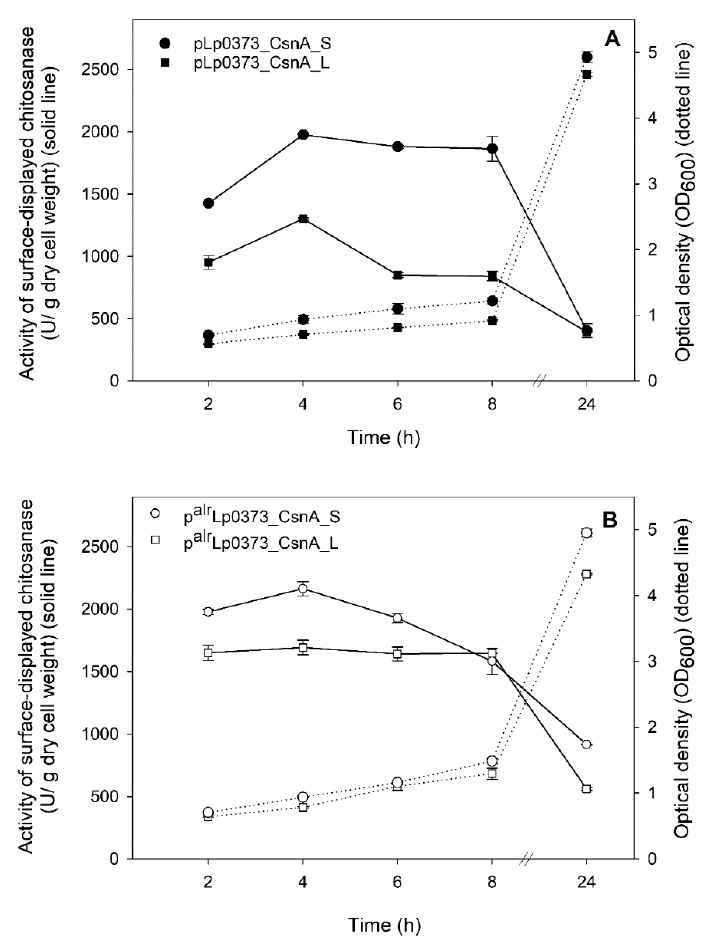
Figure 3. Enzymatic activity of CsnA displaying cells. Time course of cultivations of CsnA-displaying L. plantarum recombinant strains harboring the plasmids of erm -based expression system ( A ) and alr -based expression system ( B ) in MRS medium at 37 °C. Experiments were performed in triplicates, and the standard deviation was always less than 5%.